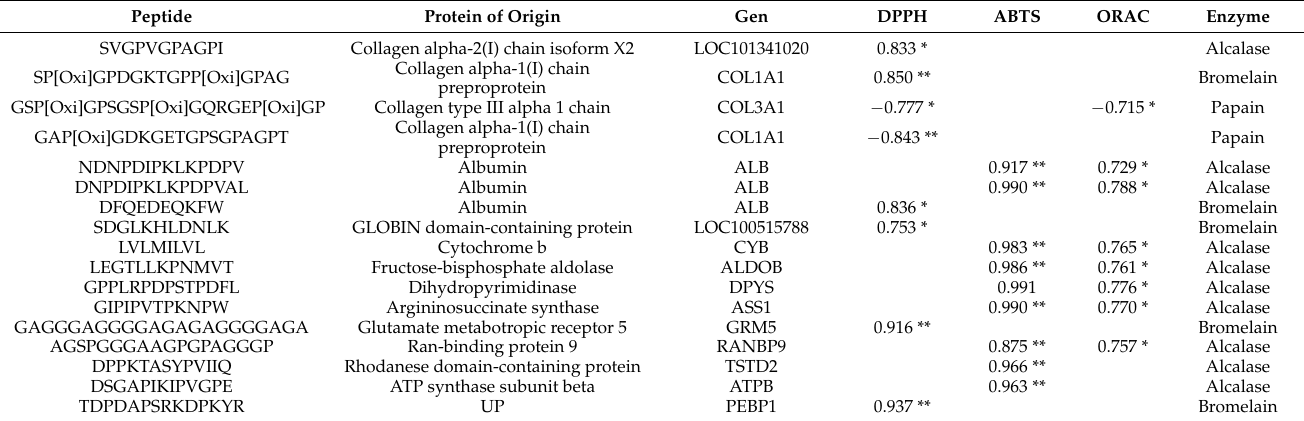
Table 4. Correlations between antioxidant capacity and peptide quantification obtained from alcalase, bromelain, flavourzyme, and papain treatments on pork